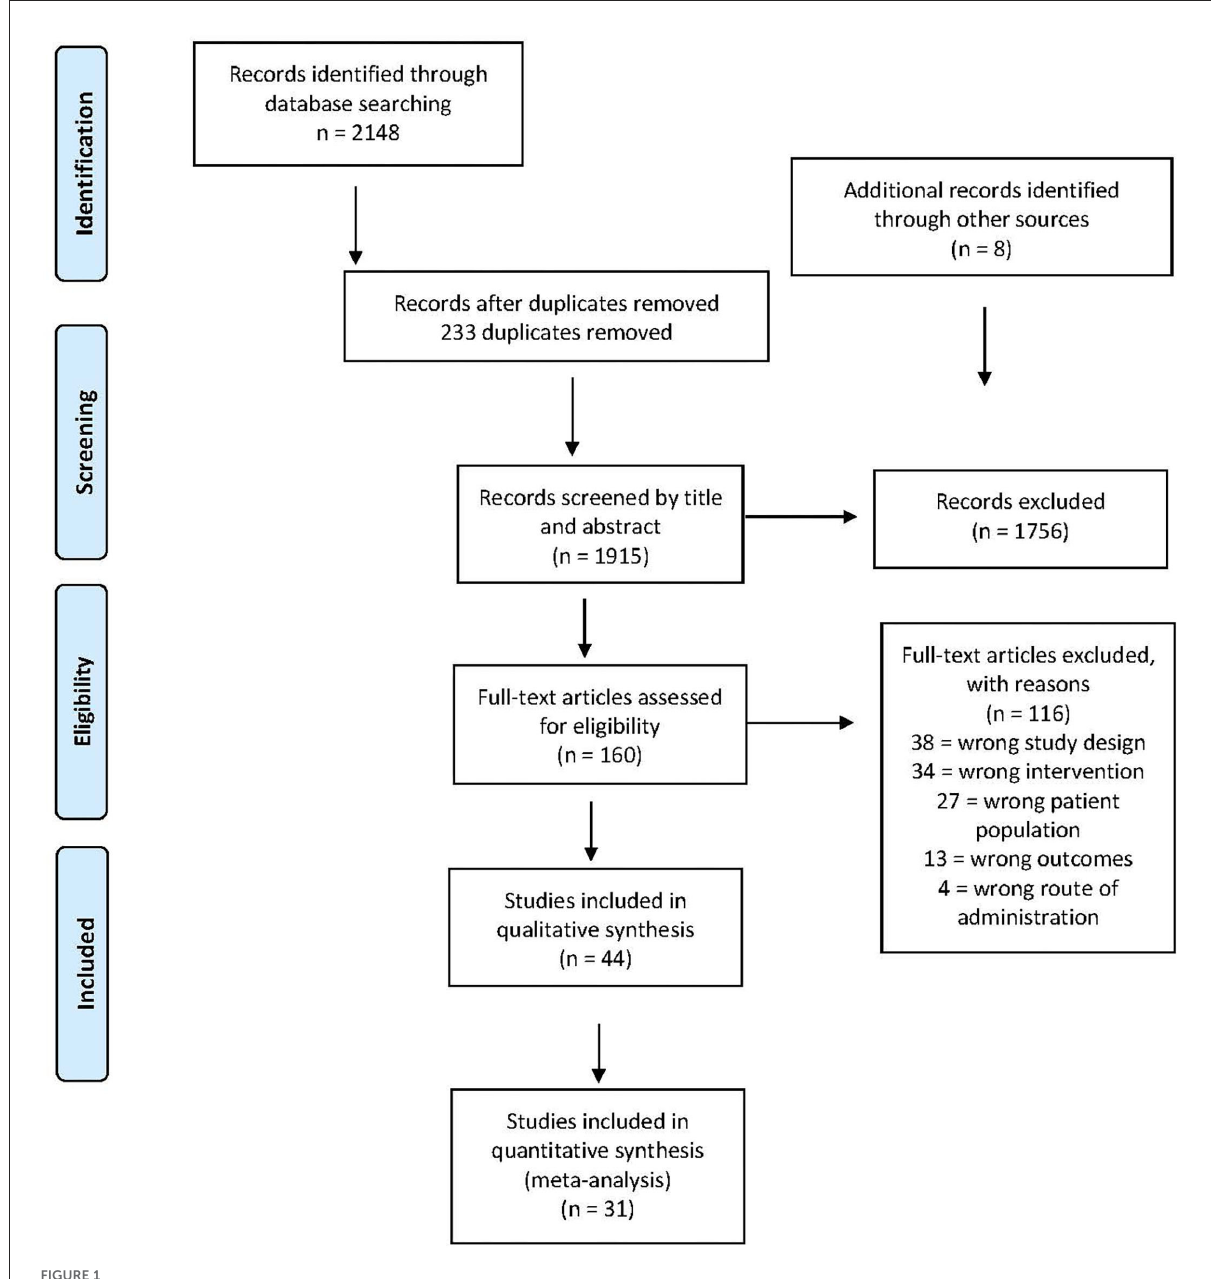
FIGURE1 Prisma flow